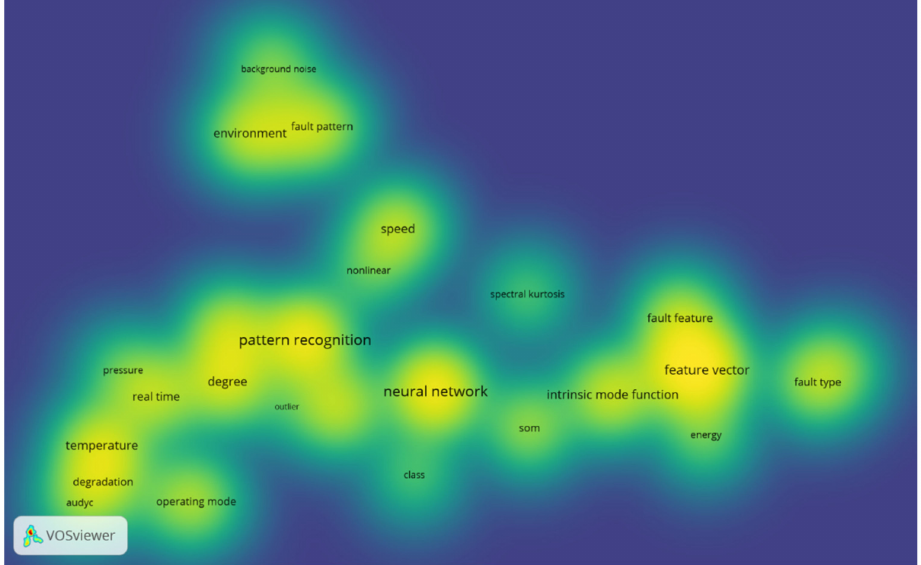
Figure 4. Density visualization for title and